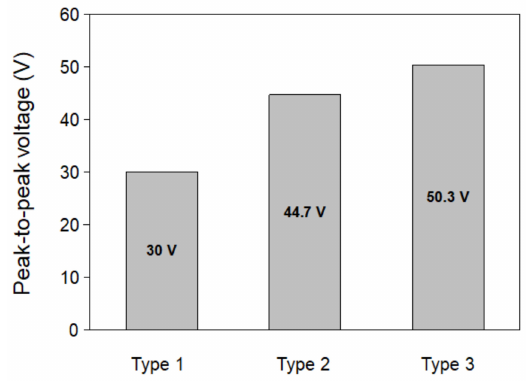
Figure 5. The maximum peak-to-peak output voltage of Type 1–3